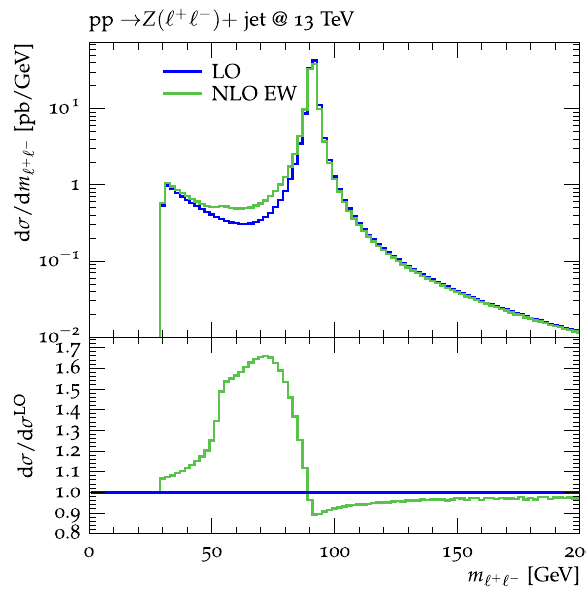
Fig. 4 Dilepton invariant-mass distribution in pp → (cid:3) + (cid:3) − + jet for m (cid:3)(cid:3) ∈ [ 30 , 200 ] GeV comparing LO and NLO EW. Collinear lepton– photon pairs with R γ(cid:3) < 0 . 1 are